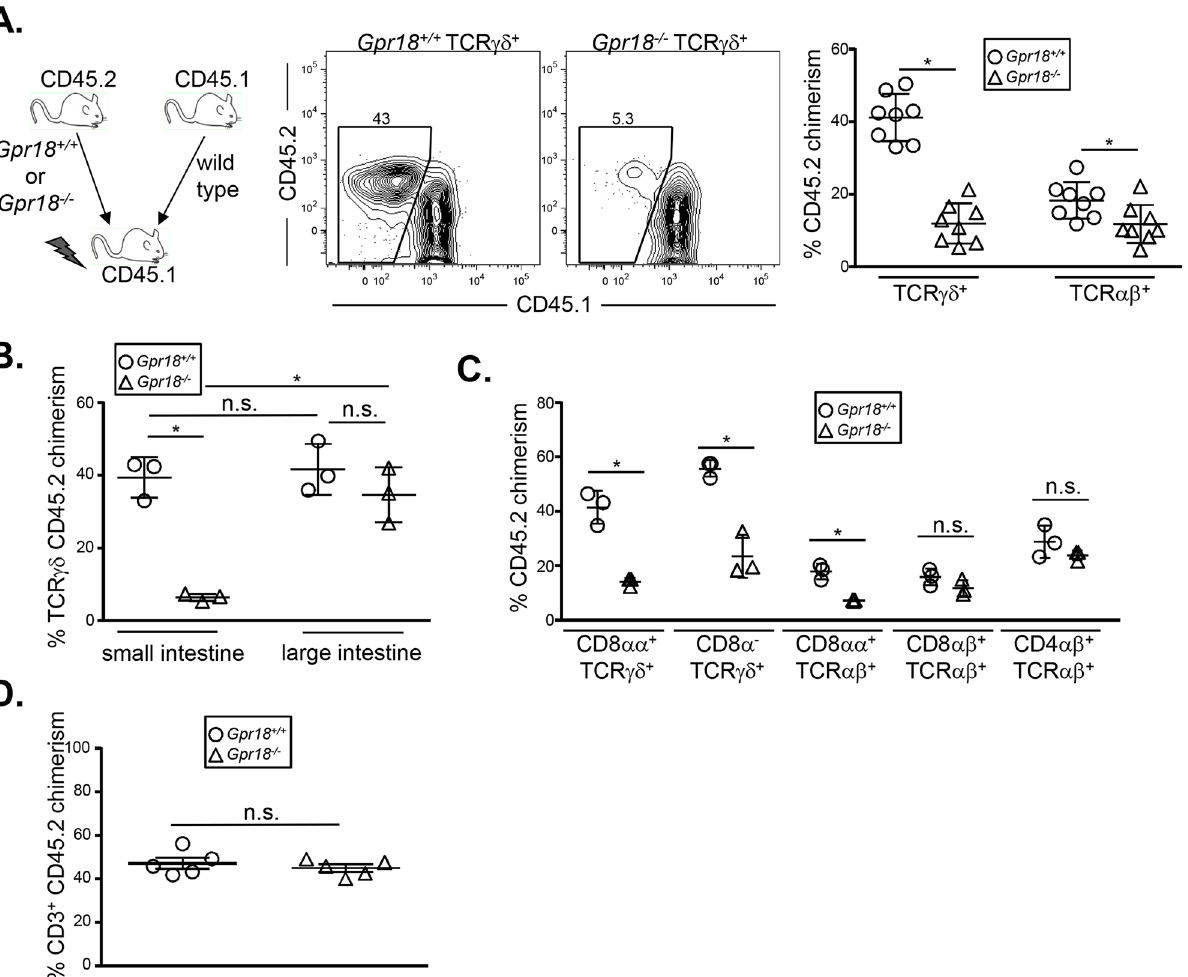
Fig 3. GPR18 is essential for optimal IEL reconstitution following bone marrow transplantation. Donor chimerism analysis of T cells in the intestine and spleen. Equal numbers of wild type CD45.1 + and either Gpr18 +/+ or Gpr18 -/- CD45.2 + bone marrow cells were transplanted into 800cGy-irradiated CD45.1 + recipients. Eight weeks after reconstitution, small (A, C) or both small and large (B) intestines were harvested and donor CD45.2 + chimerism in TCR γδ and TCR αβ (A, B) and specific IEL subsets (C) were analyzed by flow cytometry. (D) Total splenic T cell chimerism is shown. Gating strategies are shown in S1 Fig. Mean values ± SEM are shown. * p < 0.05 using student's 2-tailed unpaired